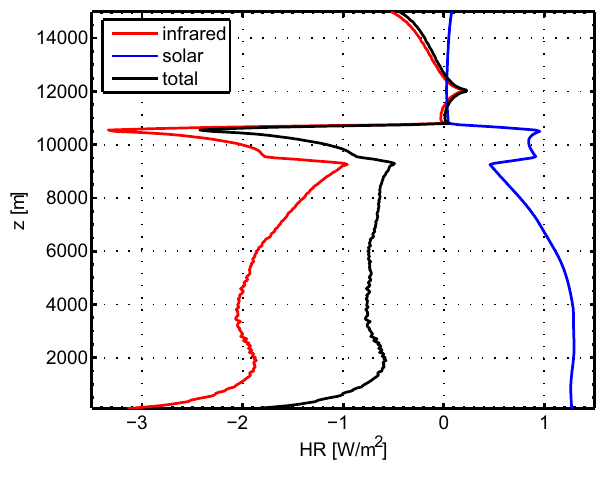
Fig. 3. Vertical radiative heating rates (split into solar, infrared and total) at the initial time step, containing an ISSR with maximum RHi of